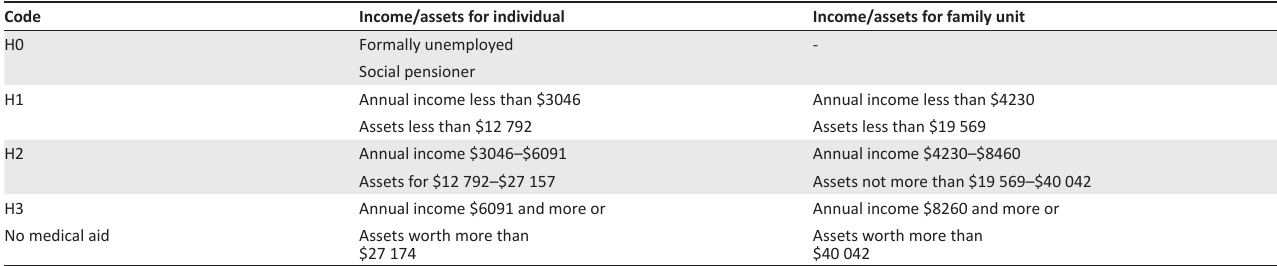
TABLE 1-A1: Financial classification codes. 7